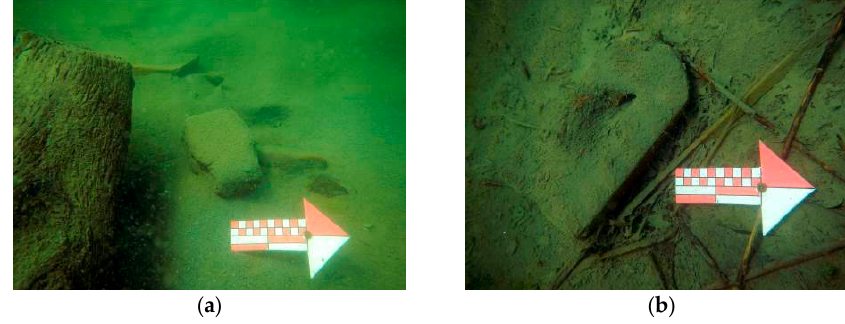
Figure 15. Silty clay downslopes during underwater surveys in Lago Tramonto, Gambulaga, Portomaggiore (FE, Italy): ( a ) Cut trunk, bricks, and tiles; ( b ) fragment of brick (photo by Giovanna Bucci).